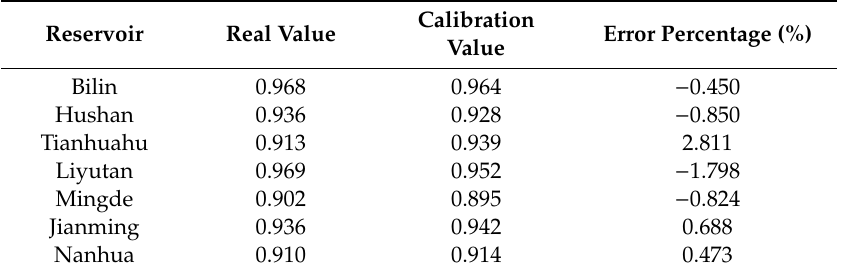
Table 11. The calibration results of reasonable WSRI estimation function for seven selected reservoirs for which the planned water supply amount had been decided.